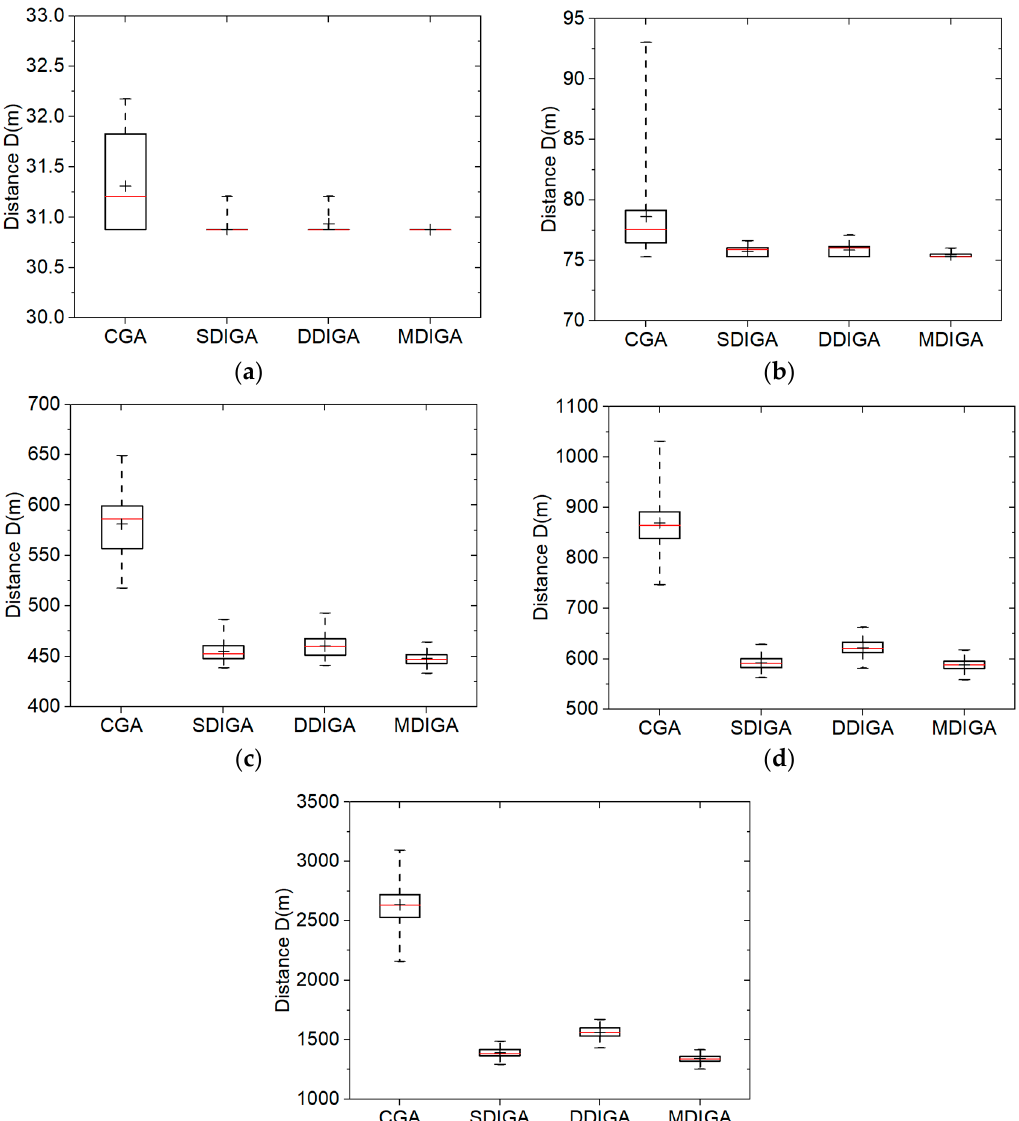
Figure 7. Solution distribution of each algorithm with five numbers of planned points: ( a ) P = 14; ( b ) P = 22; ( c ) P = 51; ( d ) P = 76; ( e ) P = 99. Table 4. Statistics results of optimal path distance in 100 runs with five numbers of planned points.